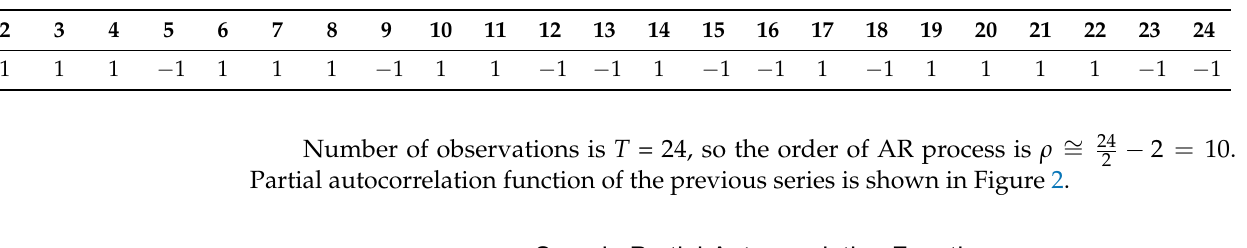
Table 2. Two-state time series.